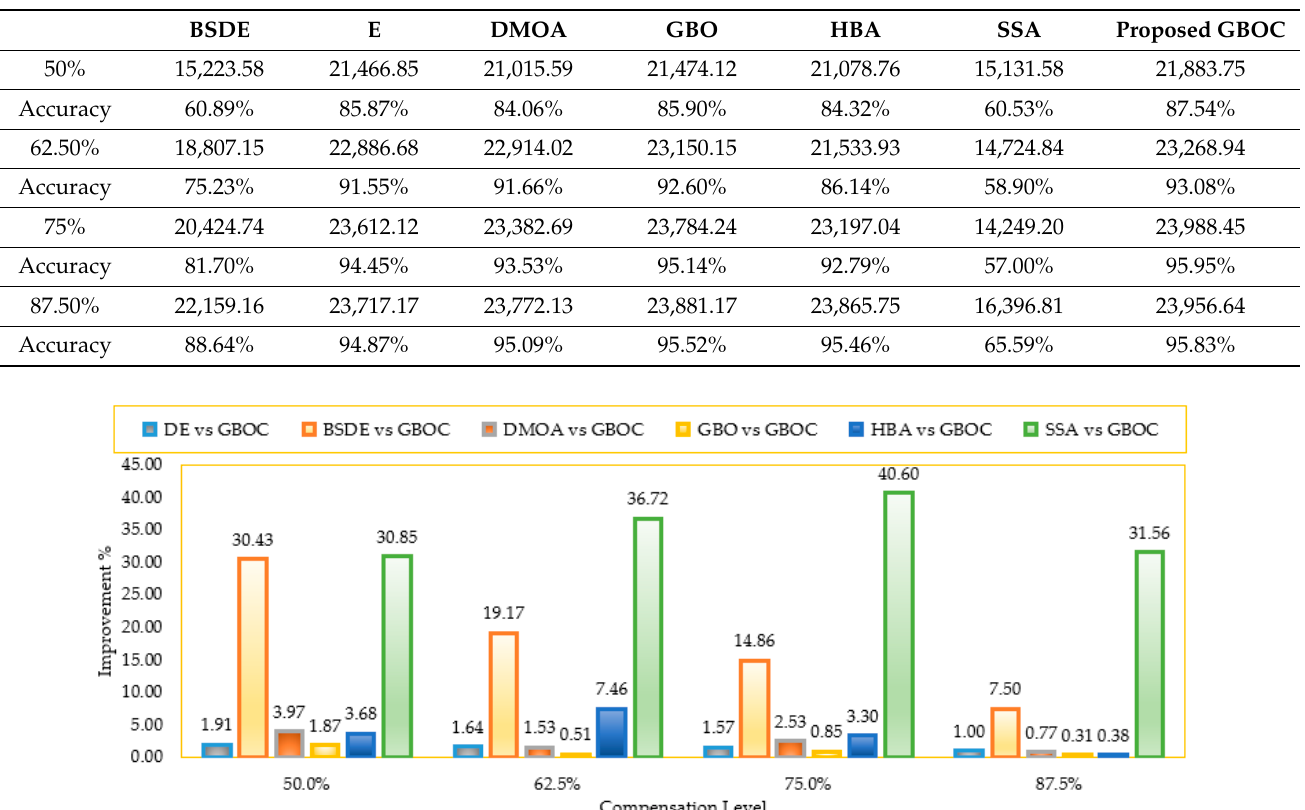
Table 4. Obtained objectives and related accuracies of all of the applied techniques with improved compensation levels.